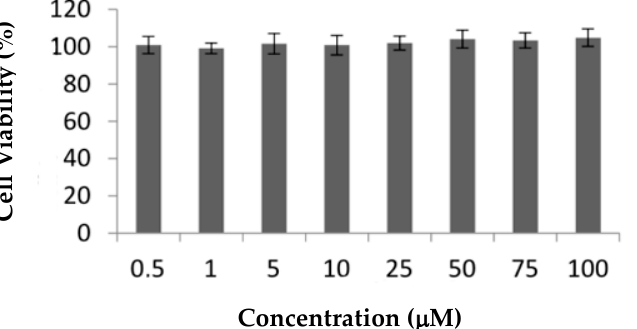
Figure 3. Effect of Ru2 on cellular viability of nontumor cell line fibroblasts. Cells were exposed to 0.5–100 µ M of compound or 0.1% ( v / v ) DMSO (vehicle control) for 72 h. The results are expressed as mean ± SEM fold-change compared to controls of at least three independent experiments.